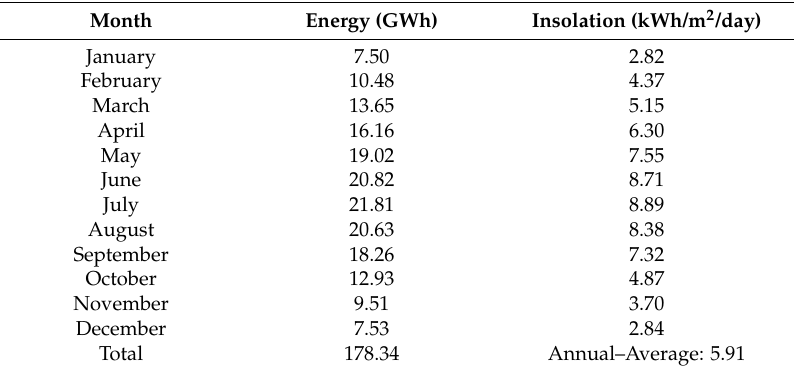
Table 2. Monthly production and insolation of the FPPP.